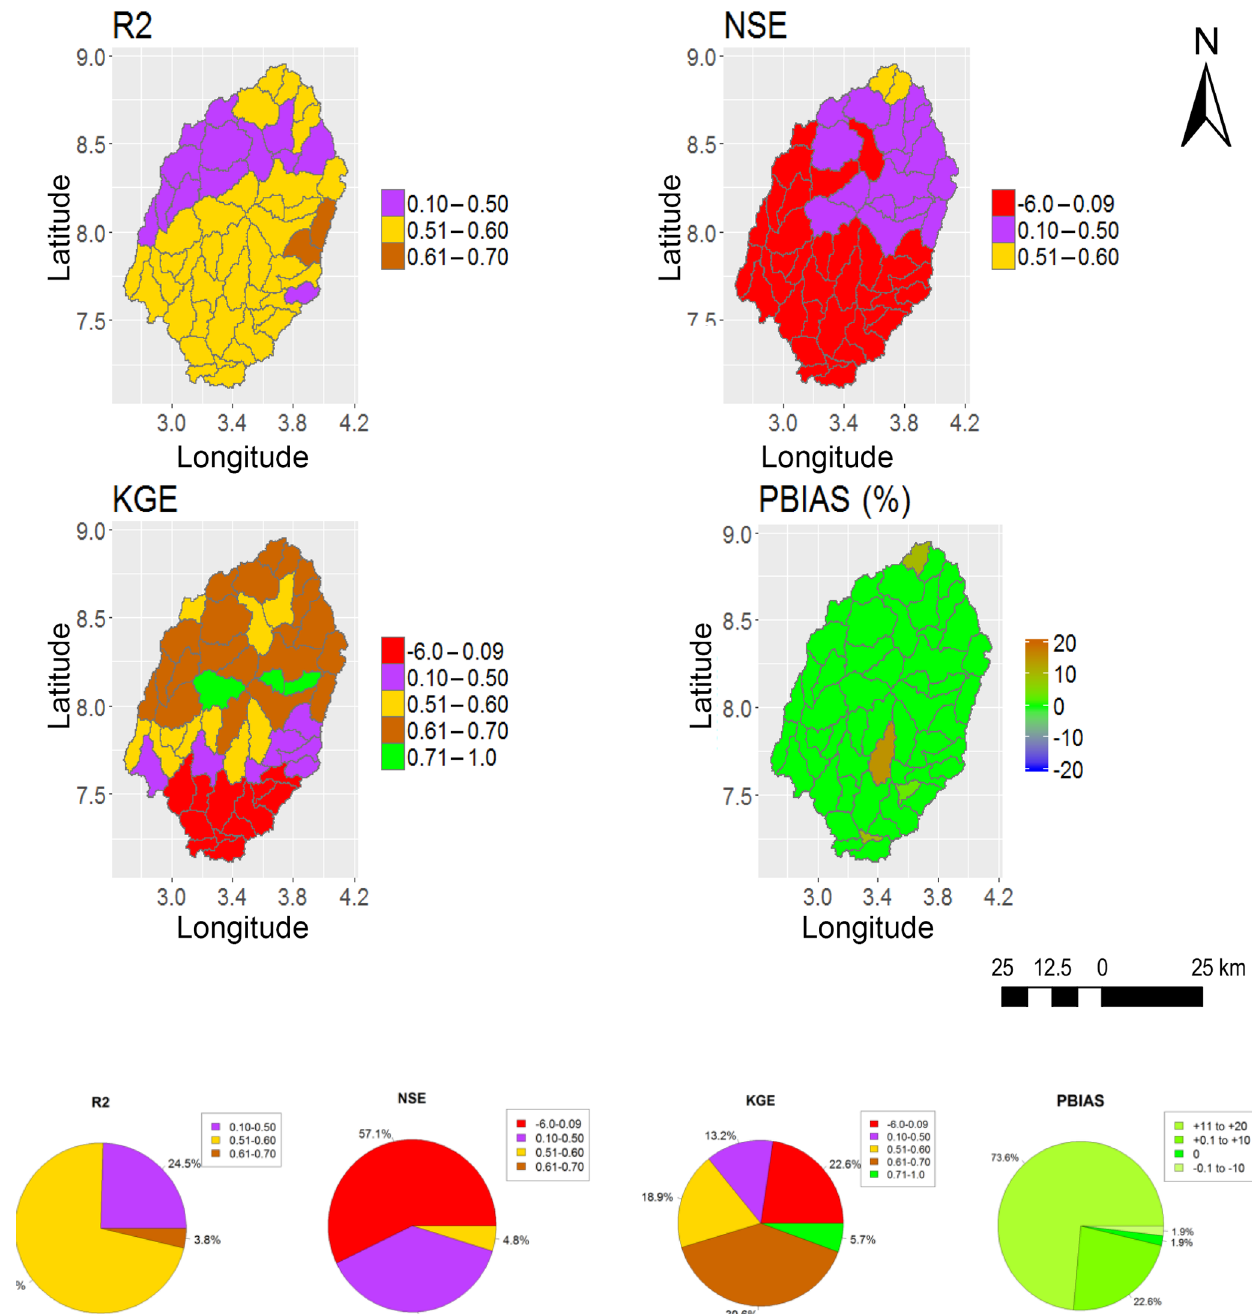
Figure 6. Performance metrics (NSE, KGE, R 2 and PBIAS) of SWAT (SWAT_P-M) when calibrated with MOD16 (MS6).